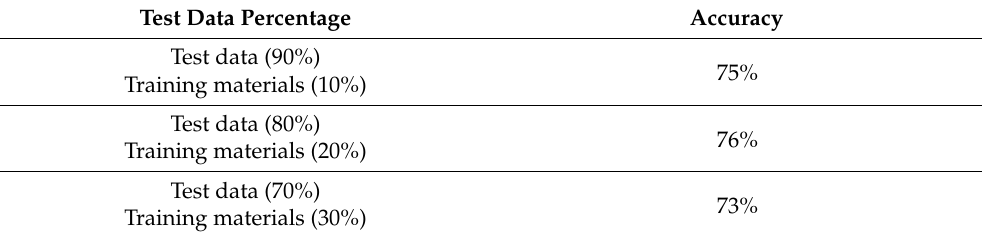
Table 4. Model accuracy under different training data.